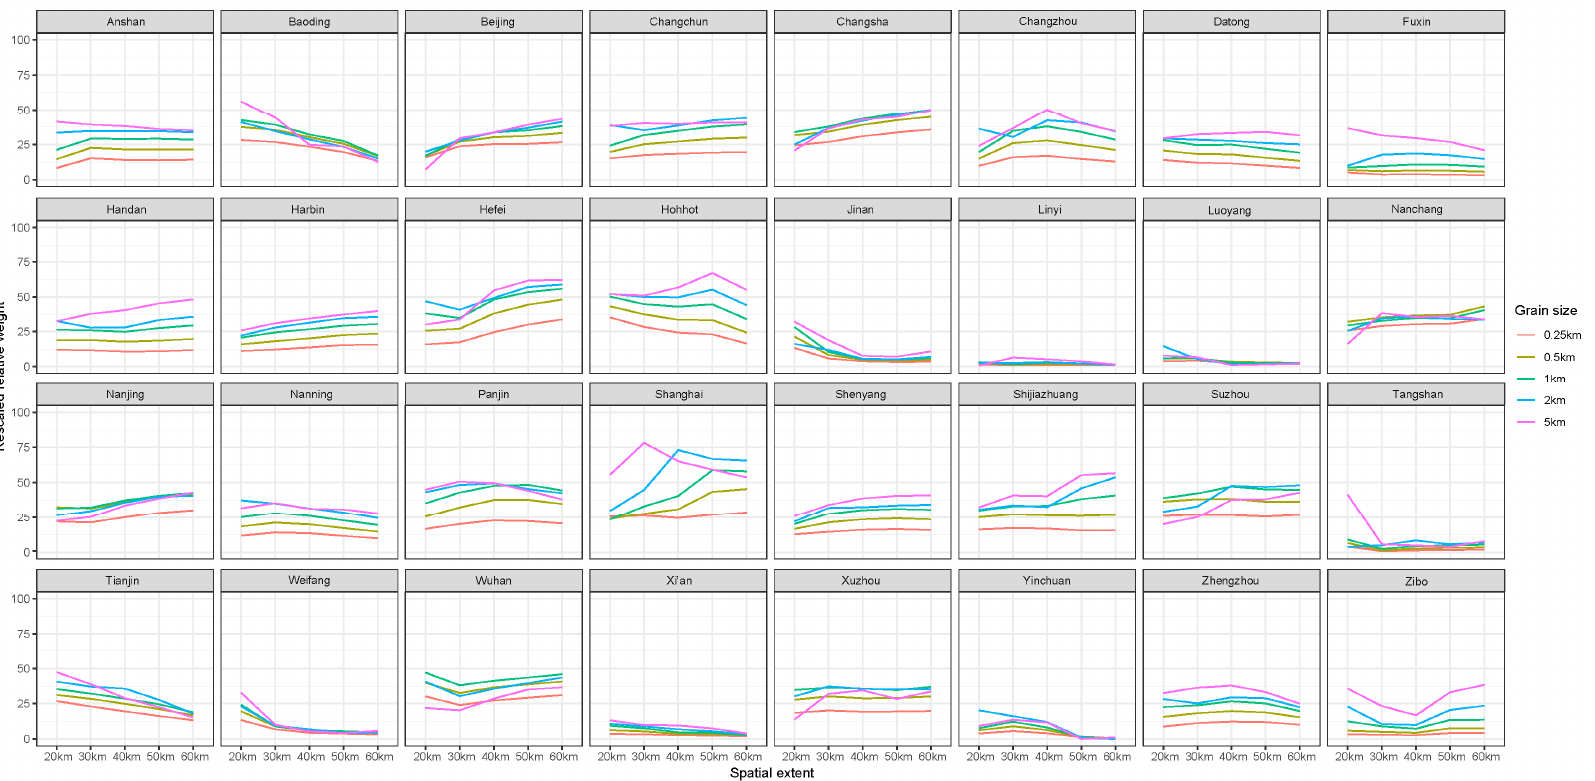
Figure A18. Relative importance of NDVI for explaning LST(Scalogram of the spatial extent).